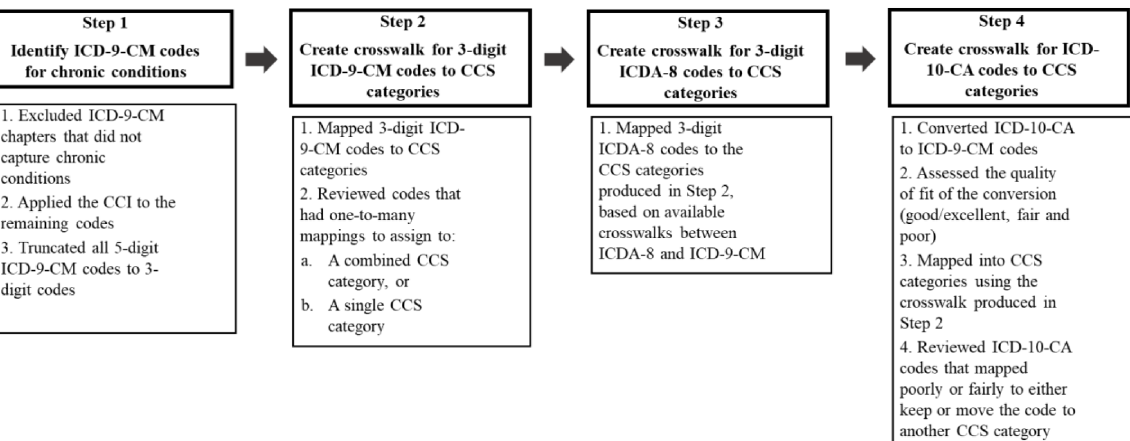
Figure 1: Diagram depicting the four steps in the mapping